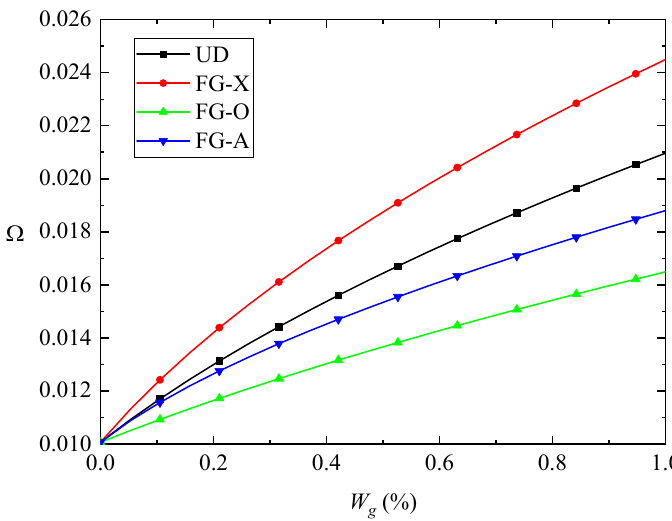
Figure 4. Effects of GPL weight fraction on the fundamental frequency of C-F FG-GPLRC circular arch ( θ 0 = π/3, λ = 1/10).